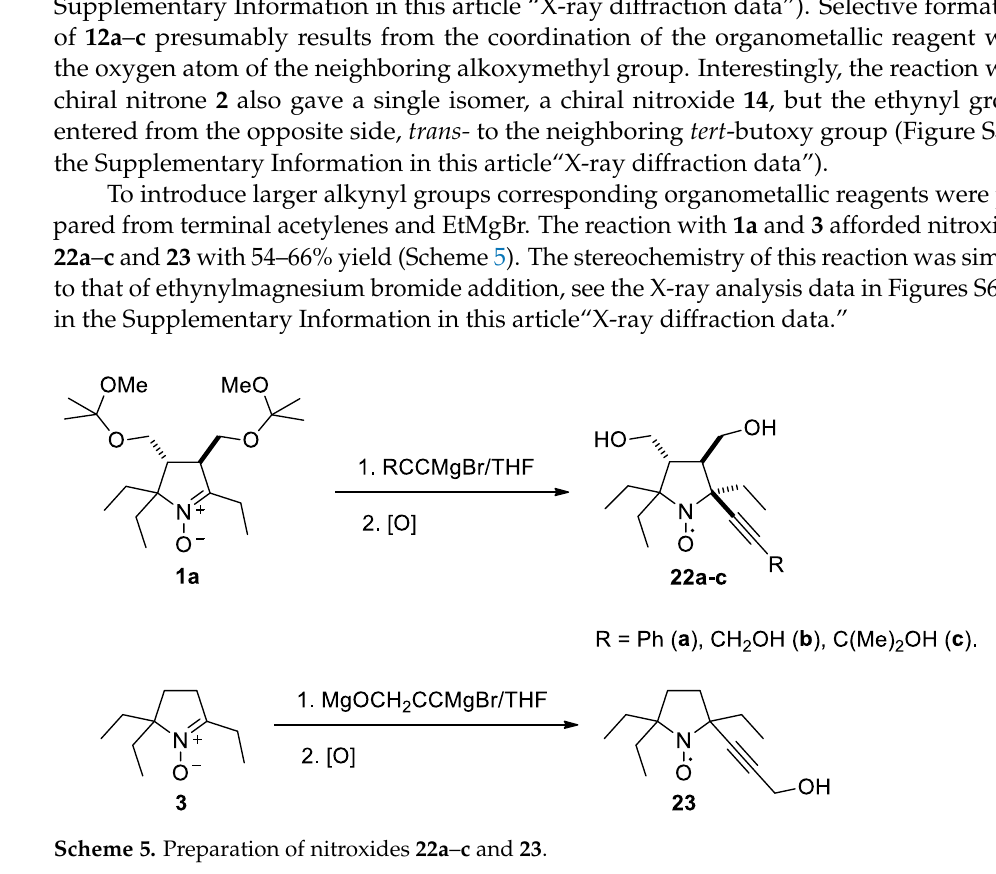
Scheme 5. Preparation of nitroxides 22a – c and 23 .